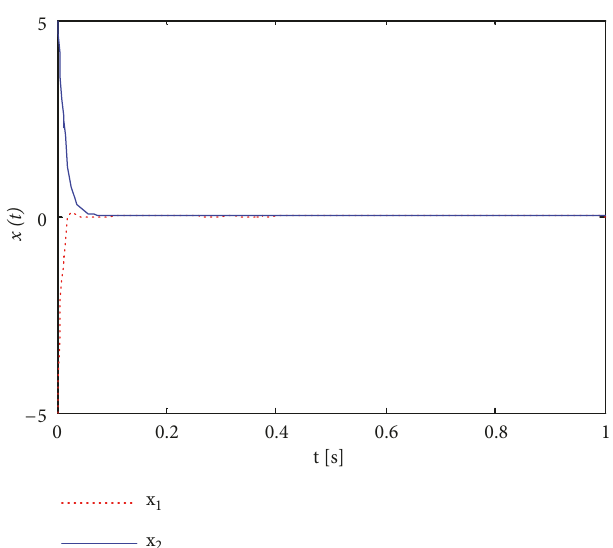
Figure 1: State response curve of closed-loop system controlled by memory state feedback controller.